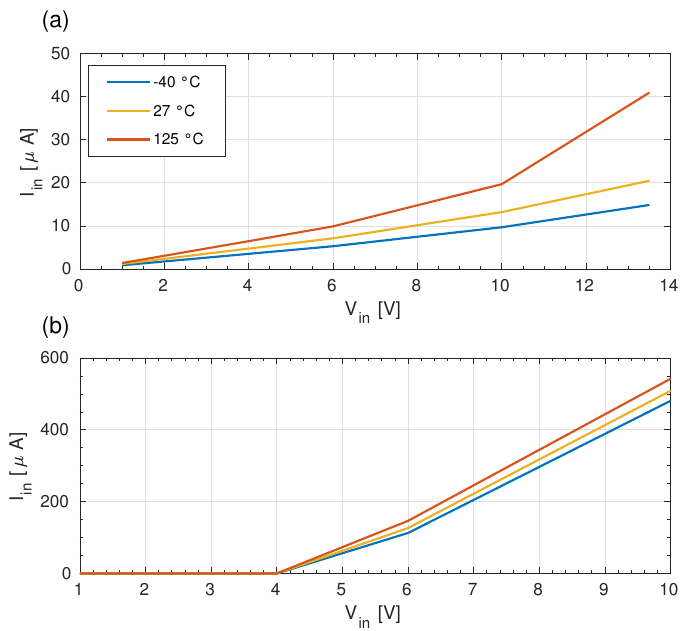
Figure 15. Measured input currents of the circuits for injector signals vs. forced input voltage, at − 40 ◦ , 27 ◦ , and 125 ◦ chip temperatures. ( a ) Input current of the interface circuit for the low-side signal in Figure 4. ( b ) Input current of the circuit in Figure 6 for the acquisition of the low-side